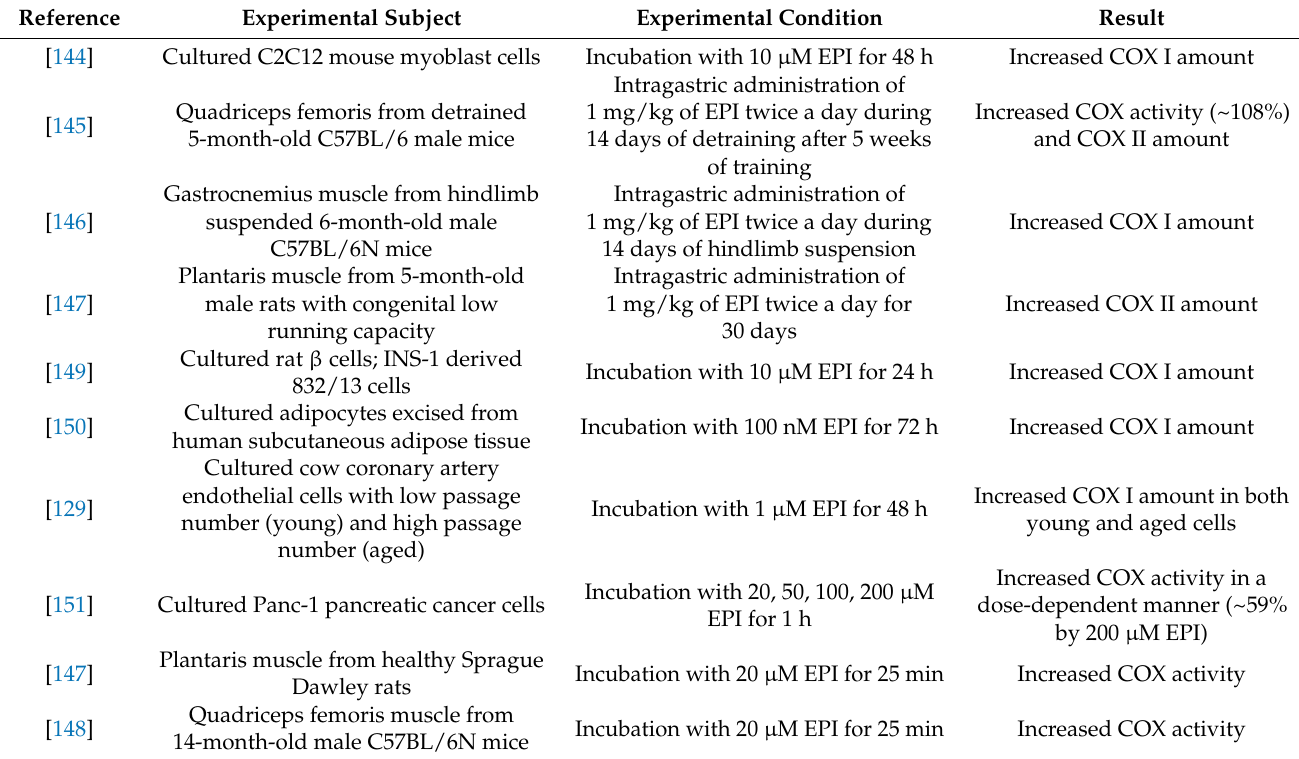
Table 2. Effect of ( − )-epicatechin (EPI) administration on cytochrome c oxidase